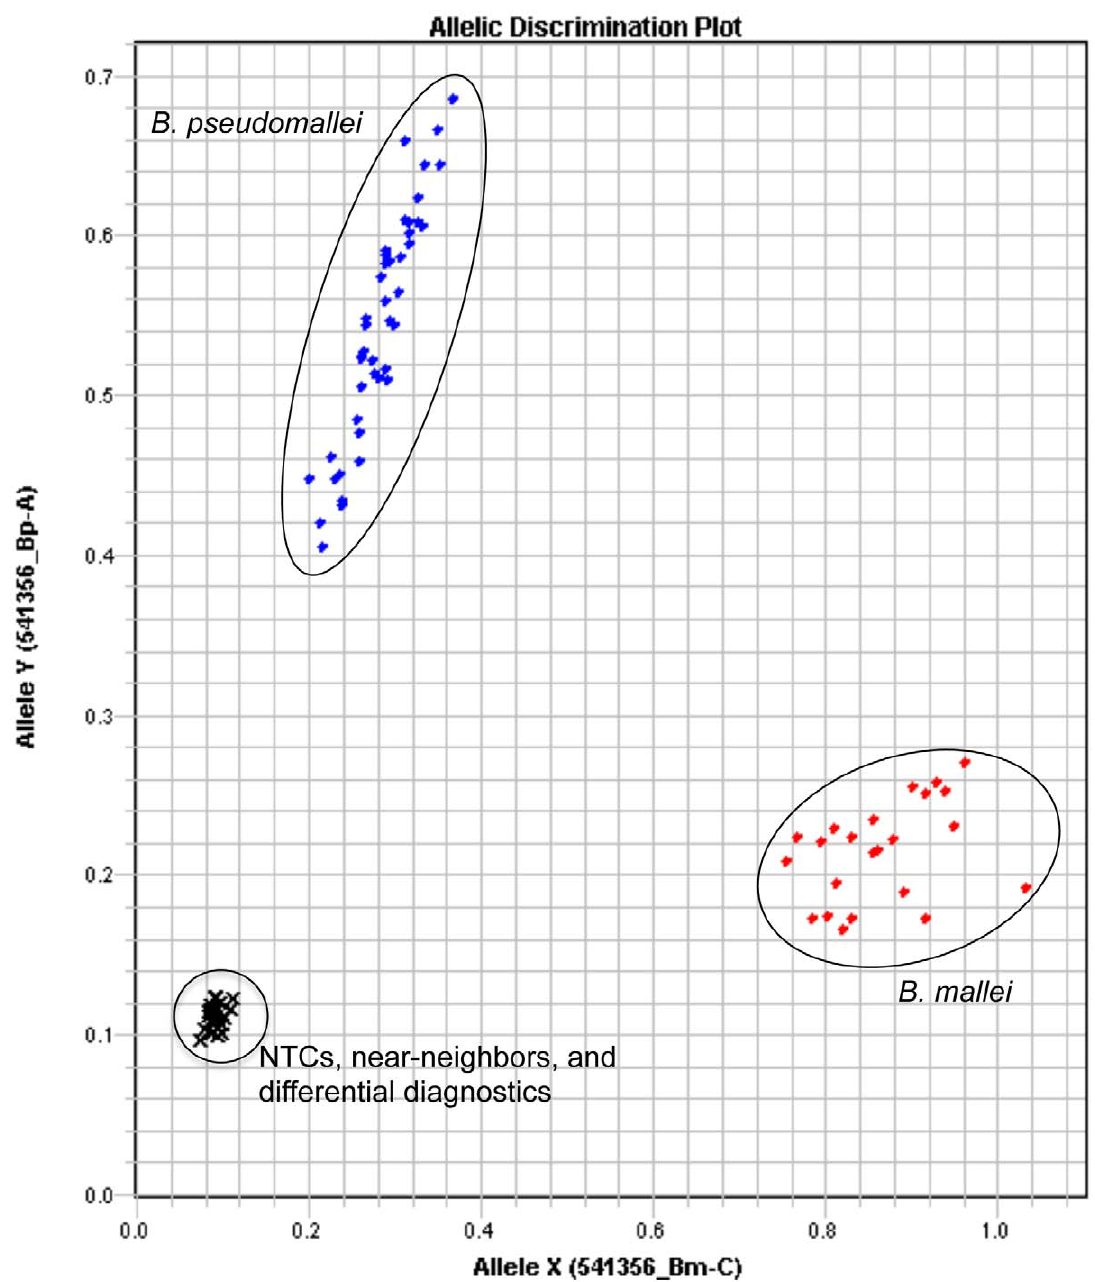
Figure 1. BurkDiff allelic discrimination plot. Results from the assay across 45 B. pseudomallei and 23 B. mallei strains are shown, along with 2 no template controls (NTCs) and 26 near-neighbor and differential diagnostic